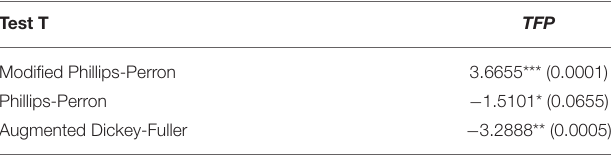
TABLE 2 | Co-integration test results of TFP and independent variables.